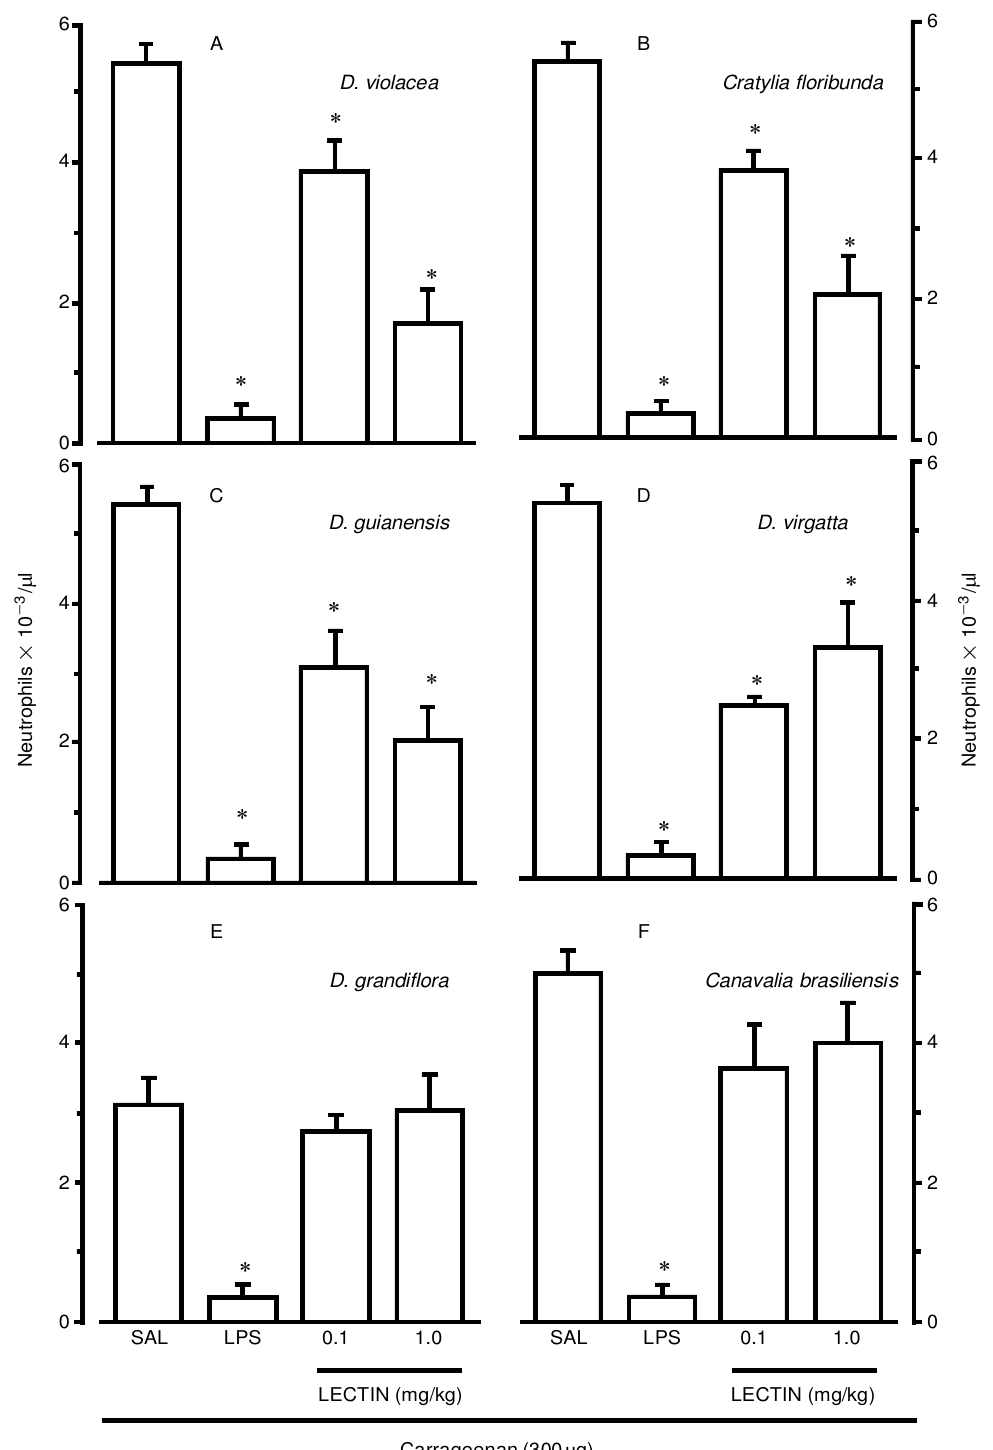
FIG. 1. Effect of i.v. injection of E. coli endotoxin (LPS) and lectins from D. violacea (A), Cratylia ¯ oribunda (B), D. guianensis (C), D. virgata (D), D. grandi¯ ora (E) and Canavalia brasiliensis (F) seeds upon neutrophil migration into rat peritoneal cavities induced by carrageenan (Cg, 300 m g). The animals were treated 30 min before the in¯ ammatory stimuli, i.v. (0 · 1 ml / 100 g), with saline (SAL), LPS (30 m g / kg) or lectins (0.1 and 1 · 0 mg / kg). The migration was evaluated 4 h after Cg injection. Values are mean SEM for the number of animals used (n = 5 - 11). The number of neutrophils present 4 h after i.p. saline injection was 0 · 47 3 10 - 3 0 · 13 / m l (n = 6). Asterisks indicate a signi® cant statistical difference ( P , 0.05, ANOVA ± Duncan’s test), compared to the SAL control